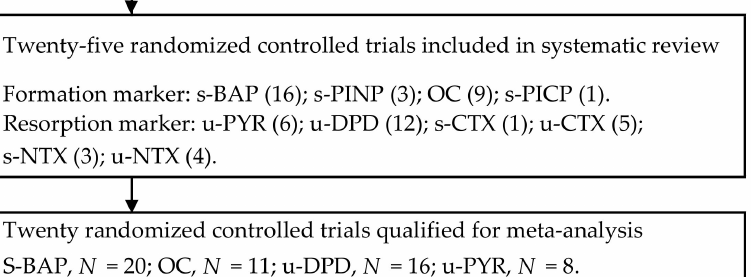
Figure 1. Flow diagram of literature search and research selection procedure. N , number of compar- isons; (), number of trials; s, serum; u, urine; ALP, total alkaline phosphatase; BAP, bone alkaline phosphatase; CTX, C-terminal telopeptides of type 1 collagen; DPD, deoxypyridinoline; NTX, N- terminal telopeptide of type 1 collagen; OC, osteocalcin; PICP, C-terminal propeptides of type 1 collagen; PINP, N-terminal propeptides of type 1 collagen; PYD,